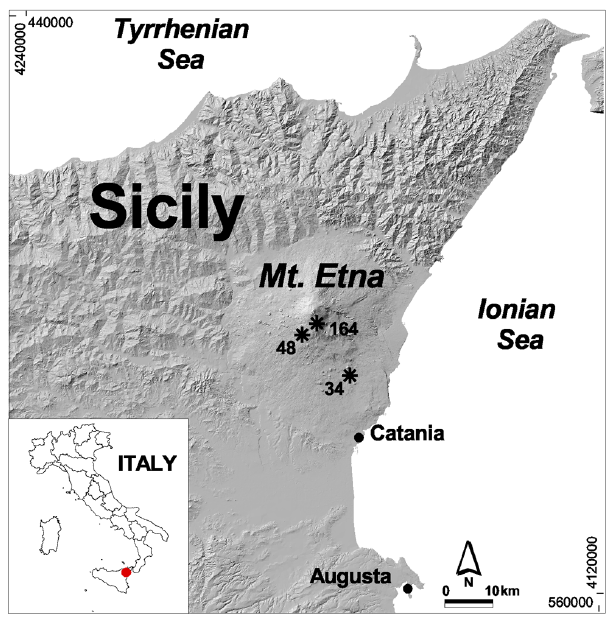
Figure 1. Location of the study area. Stars indicate stratigraphic sections of the 122 BC Etna eruption described in Figure 2.